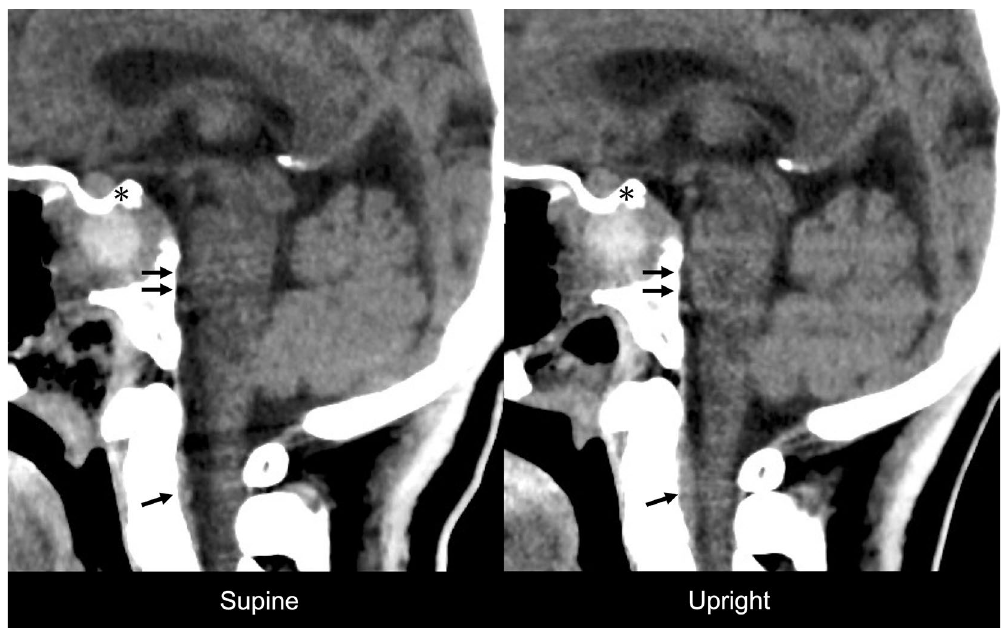
Figure 3. Computed tomography (CT) scan images with 0.5 mm slices of a 35-year-old woman who underwent cerebrospinal fluid leak closure using the endoscopic endonasal approach. Compared with supine imaging, upright CT scan revealed PBS to the ventrocaudal direction, distension of the anterior internal vertebral venous plexus (arrow), effacement of the prepontine cistern (double arrow), and enlargement of the pituitary gland (asterisk). See also Video